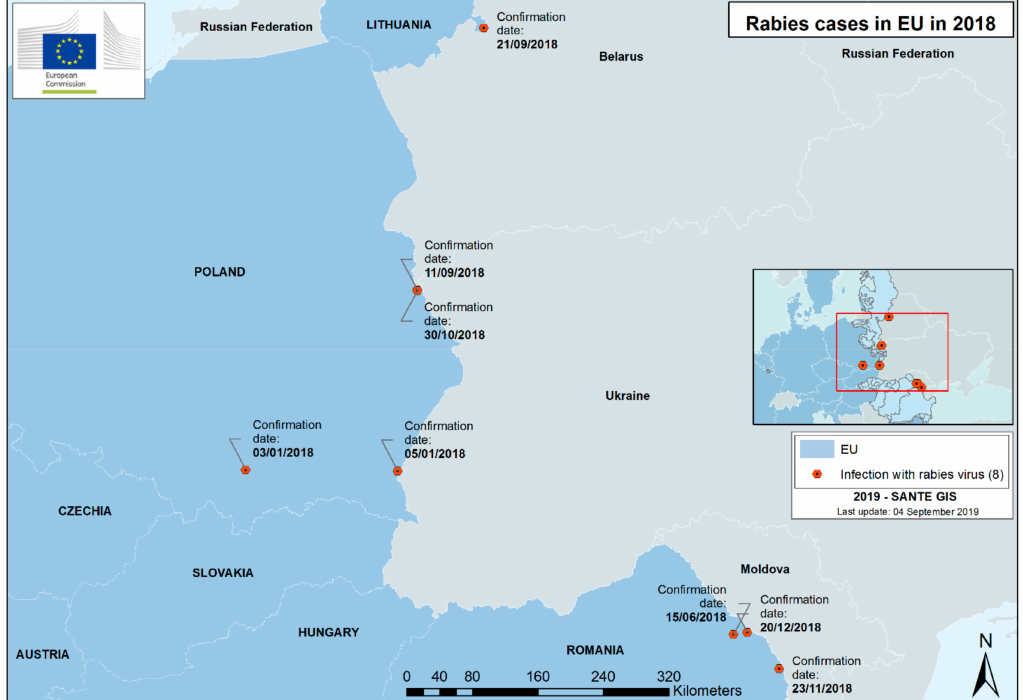
Figure 3. Rabies cases detected in the European Union in